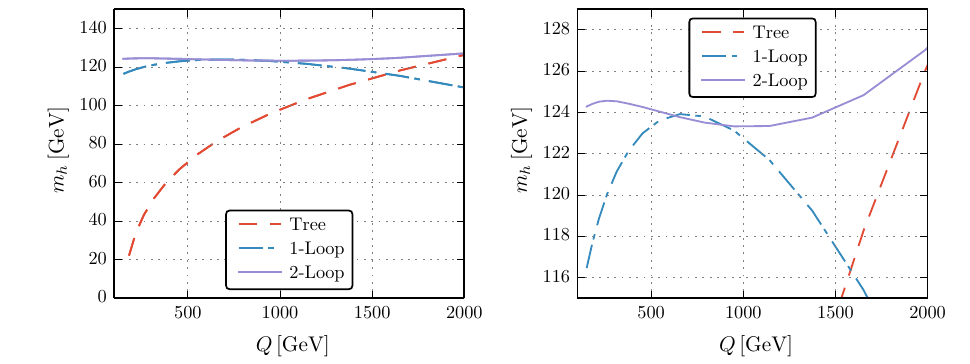
Fig. 1 Estimate of the theoretical uncertainty at a given loop level: the Higgs mass at tree (red), one-loop (blue) and two-loop level (purple) as a function of the renormalisation scale Q . As input, we use the running parameters at the top mass scale and evolve them up to Q . We have